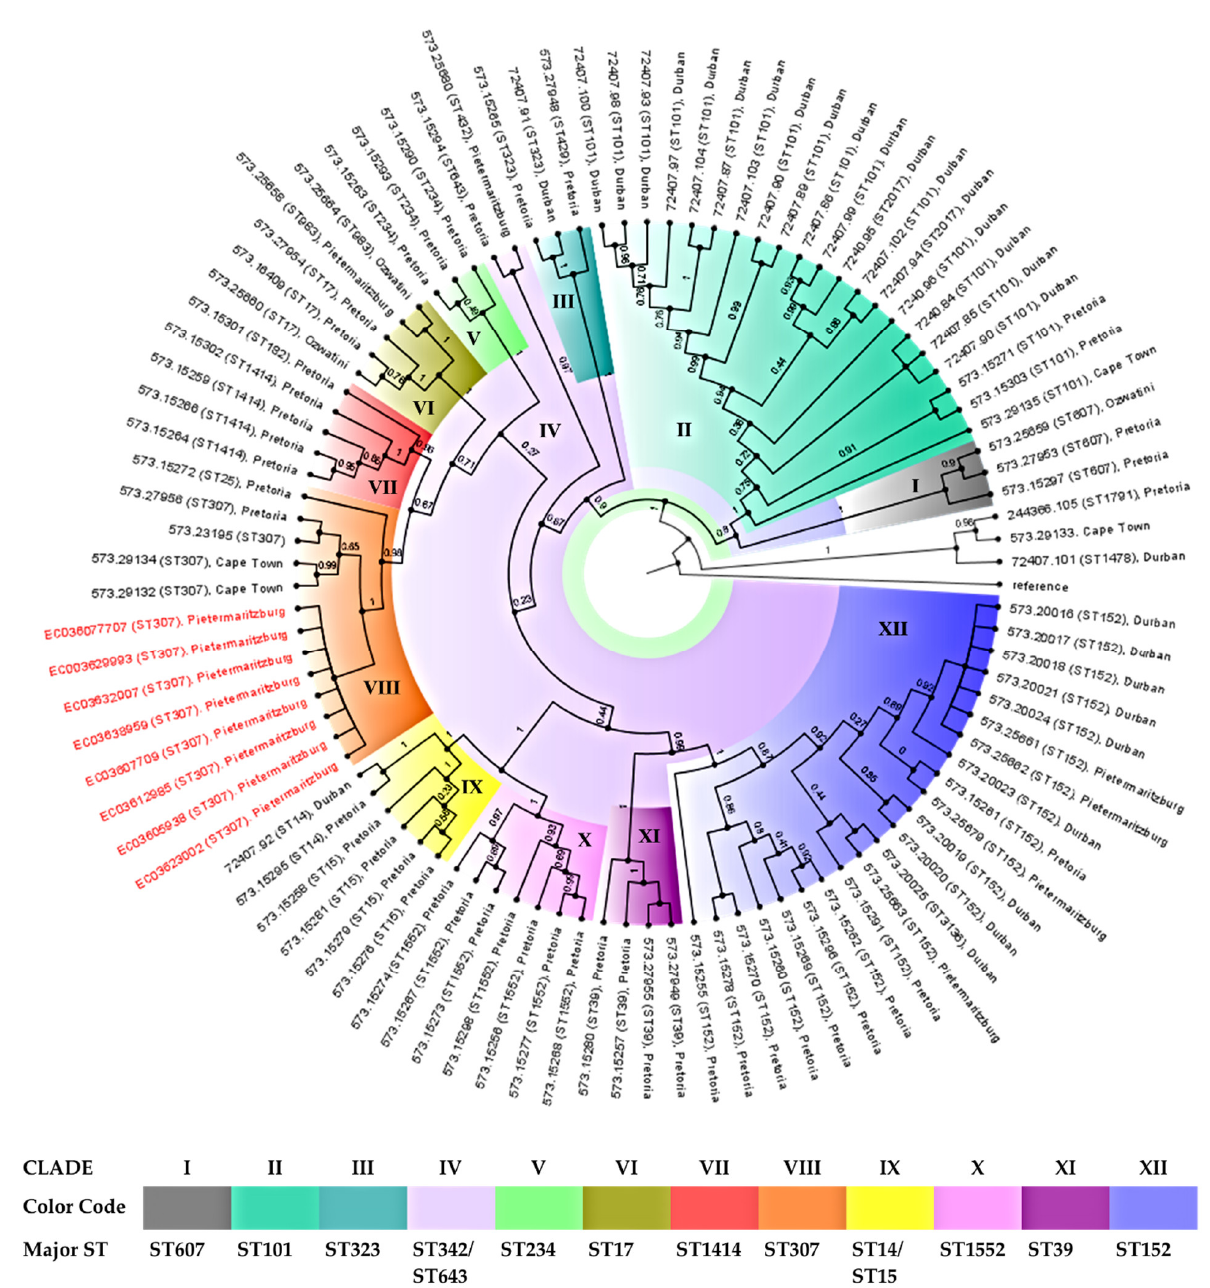
Figure 4. Phylogeography and resistance profiles of K. pneumoniae . The phylogeographic relationship between the eight K. pneumoniae isolates with other South African K. pneumoniae isolates. The Escherichia coli ATCC 25922 was used as the outgroup strain (reference genome).